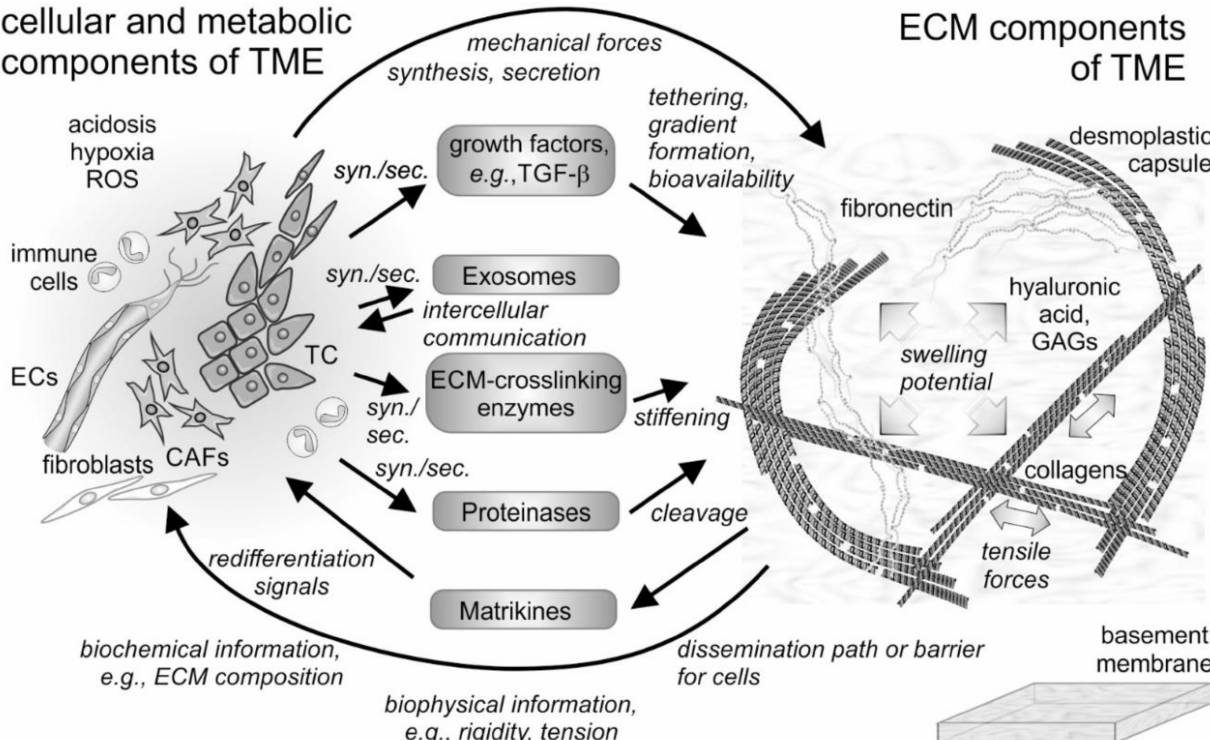
Figure 1. Cellular and non-cellular components of the tumor microenvironment (TME) and their interplay. In addition to the tumor cells (TCs), fibroblasts and their derivatives, the cancer-associated fibroblasts (CAFs), as well as ingrowing endothelial cells (ECs) and infiltrating immune cells are the cellular components of the tumor microenvironment (TME). The cells synthesize and secrete (syn./sec.) not only the extracellular matrix (ECM) components, but also growth factors, exosomes, and ECM-modifying enzymes, such as proteinases. Both cells and their secretion products interact with the fibrillar and non-fibrillar components of the ECM. Hyaluronic acid and glycosaminoglycan (GAG)-chains of proteoglycans increase the swelling potential of the interstitial space, which is counterbalanced by the tensile force-bearing fibrils of collagens, elastin and fibronectin. Modified by tethered growth factors, by crosslinking and cleaving enzymes, and by contractile forces, the ECM and its fragments with cytokine-like functions (matrikines) influence the cells within the TME in various ways. ROS, reactive oxygen